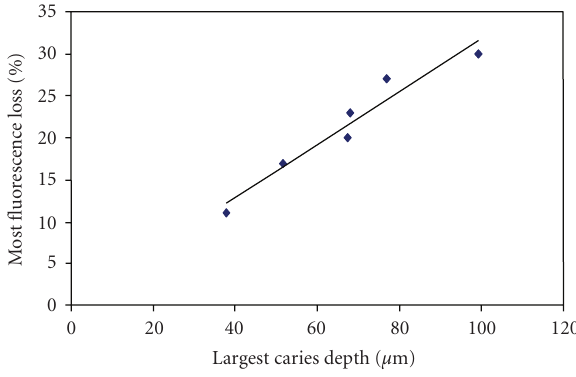
Figure 5: Linear regression analysis graph.